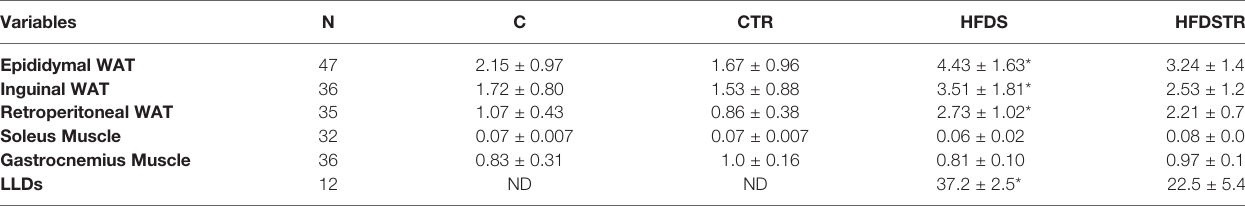
Tissues weights are expressed as g/g body mass. LLDs were expressed as a percentage. N indicates the total number of mice used. ND is non-detectable. Symbols represents pos-hoc test (P<0.05): *C vs. HFDS and # CTR vs. HFDSTR and $ HFDS vs. HFDSTR. Data are expressed as the mean ±